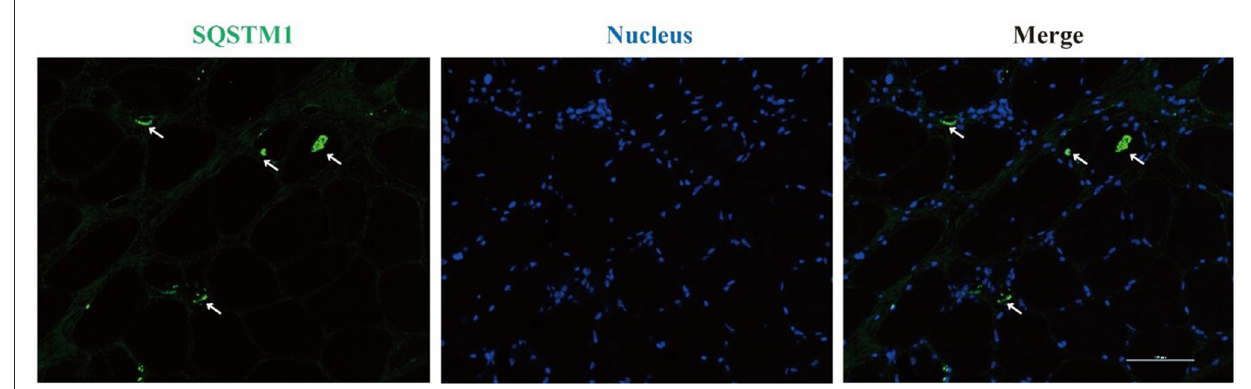
FIGURE3 Immunofluorescence staining reveals SQSTM1-positive inclusions in rimmed vacuole marked with arrows.